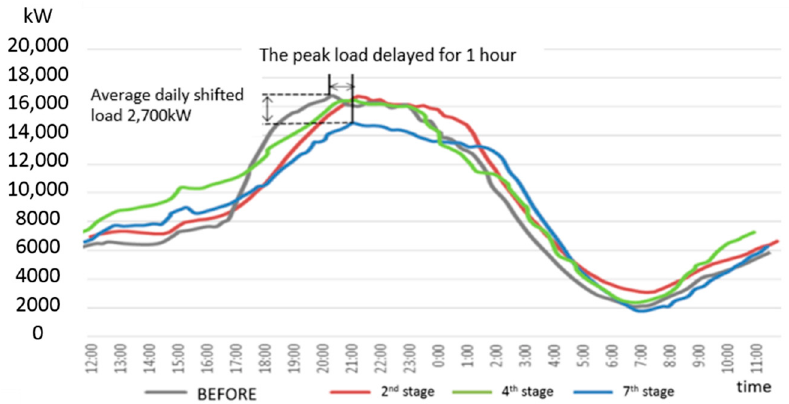
Figure 1. The effects of aggregated load regulation.